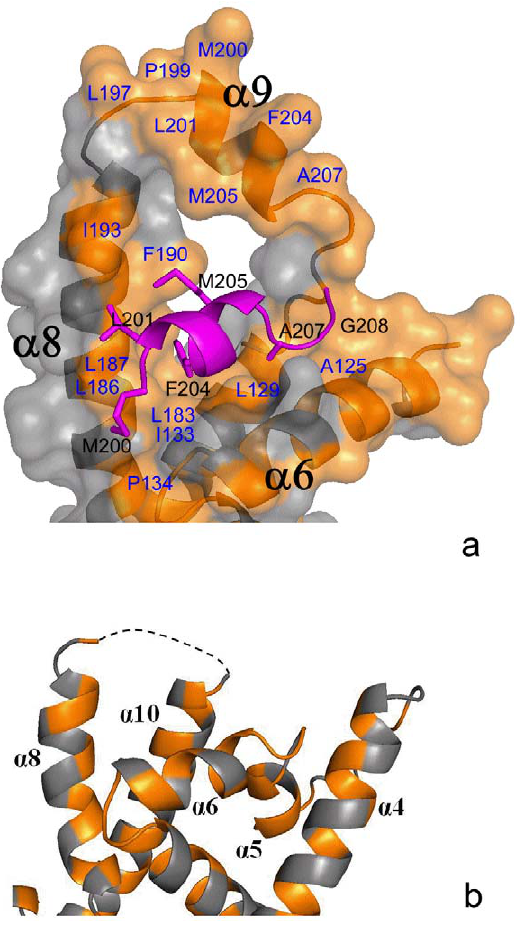
Atomic coordinates of S. cerevisia and D. hansenii Get3 have been deposited in the Protein Data Bank under the accession codes of 3H84 and 3IO3.